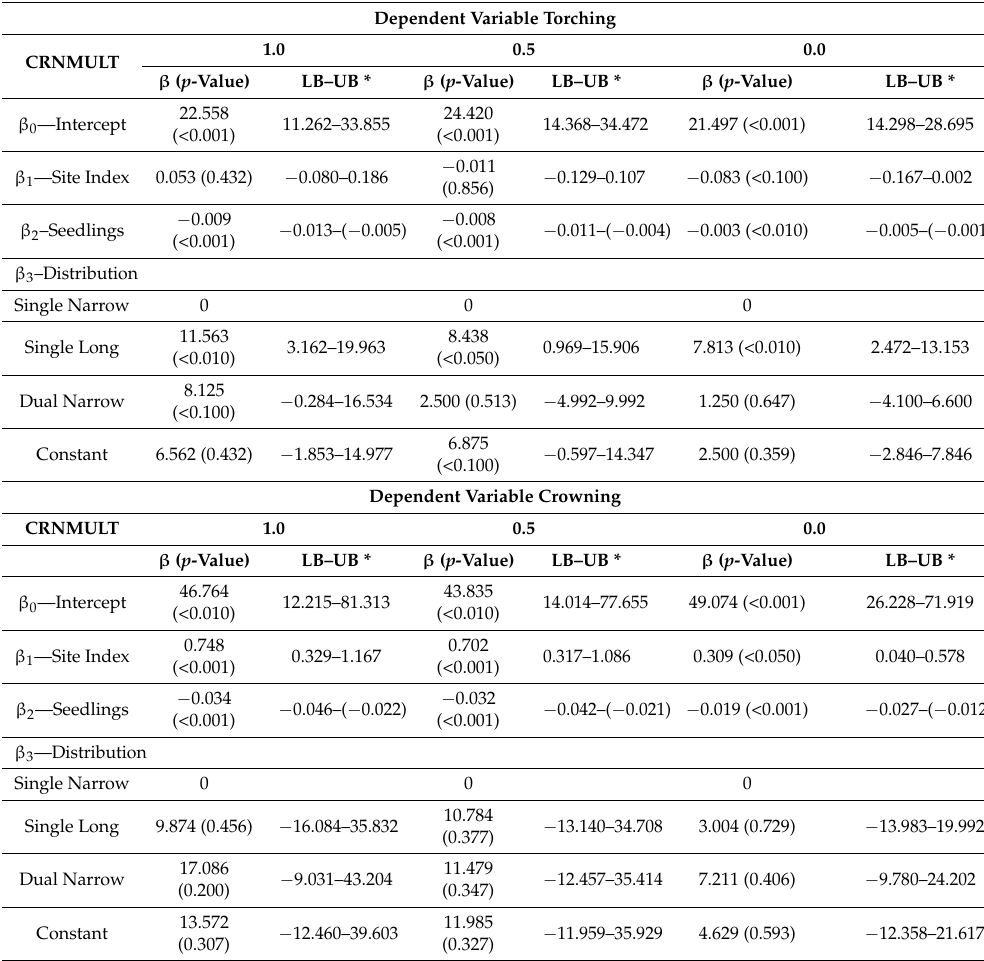
Table 4. Tobit analysis regression coefficients ( β ) for each set of simulations run at the three CRNMULT levels (i.e., 1.0, 0.5, 0.0) using the Single Narrow Distribution as the base